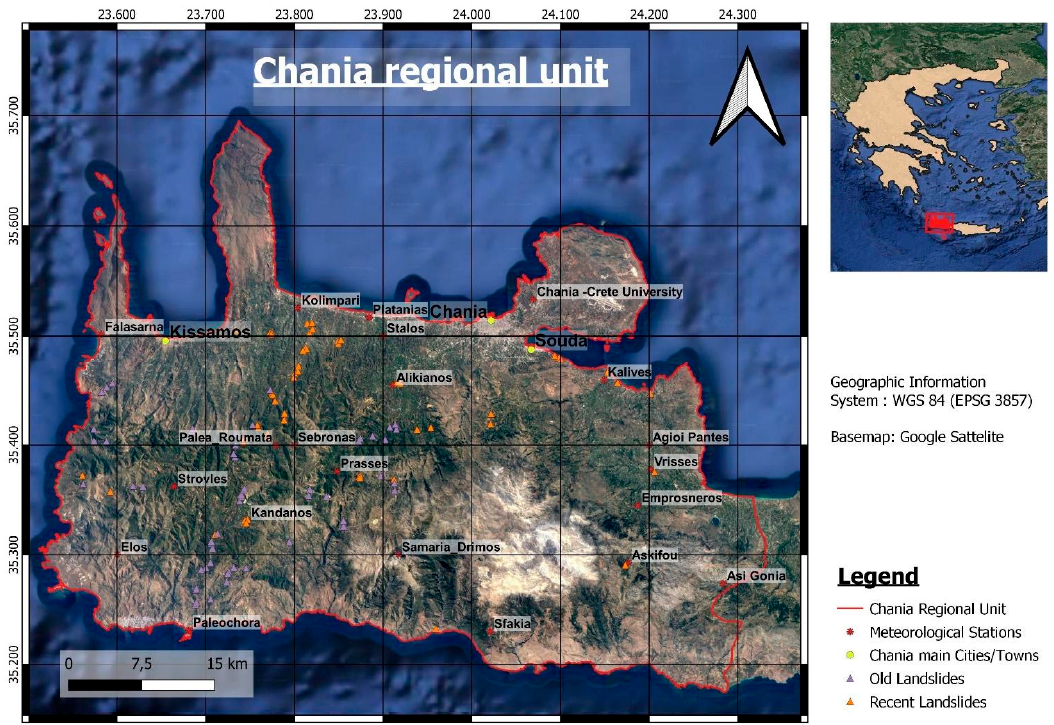
Figure 1. Spatial distribution of the meteorological stations used during this research study.